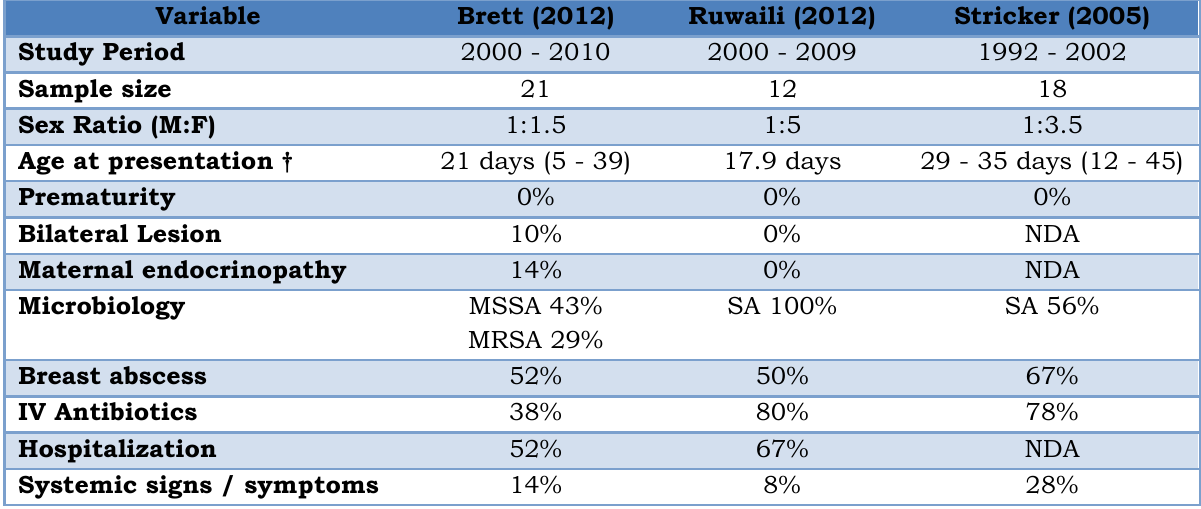
Table 2: Review of Neonatal Mastitis